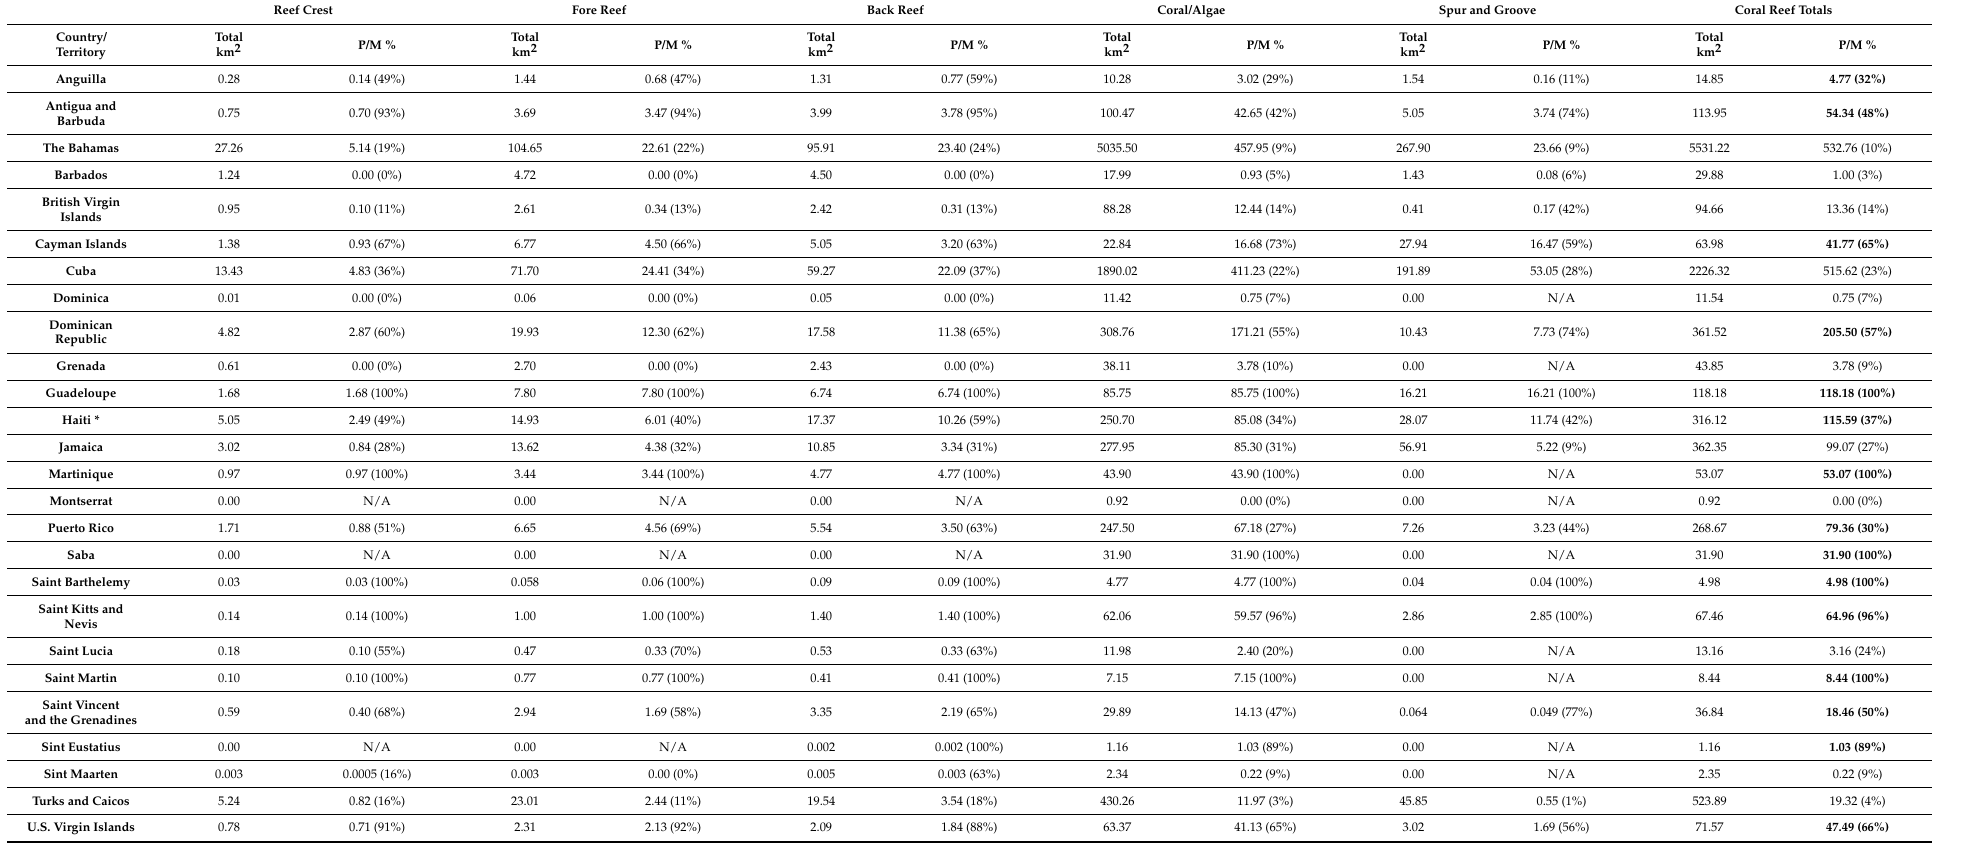
Table 5. Total area (km 2 ) of coral reef benthic habitat classes within the shallow marine zone (<30 m depth) of the Insular Caribbean per EEZ and corresponding area and percentage within declared marine protected or managed areas (P/M %). The total coral reef protection percentages in bold indicate attainment of at least 30%. ReefCrest ForeReef BackReef Coral/Algae SpurandGroove